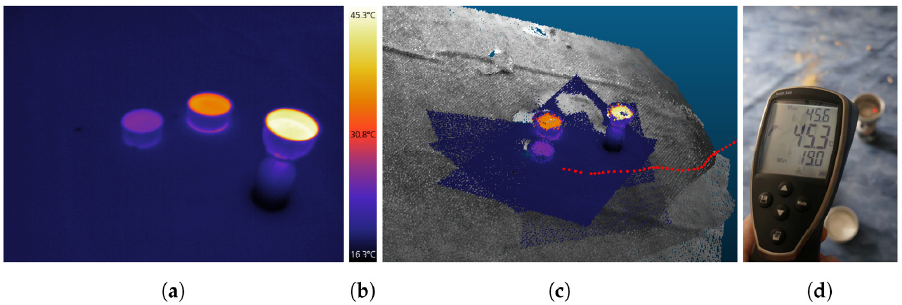
Figure 15. ( a ) Color-coded Optris PI 450 thermal image of water-filled pots. ( b ) Color bar with temperature values. ( c ) Partial 3D point cloud with trajectory (red dots). ( d ) Reference measurement with an infrared